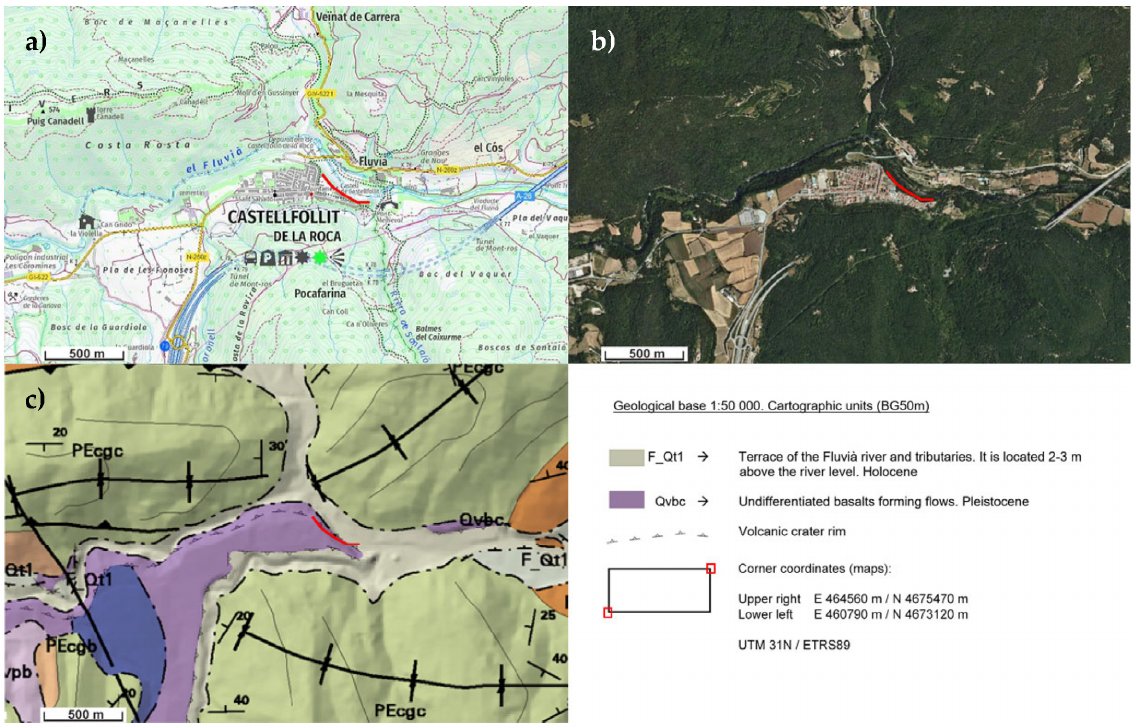
Figure 1. ( a ) Topographic map, ( b ) ortophotography and ( c ) geological map, the study area is highlighted with a red line in all of